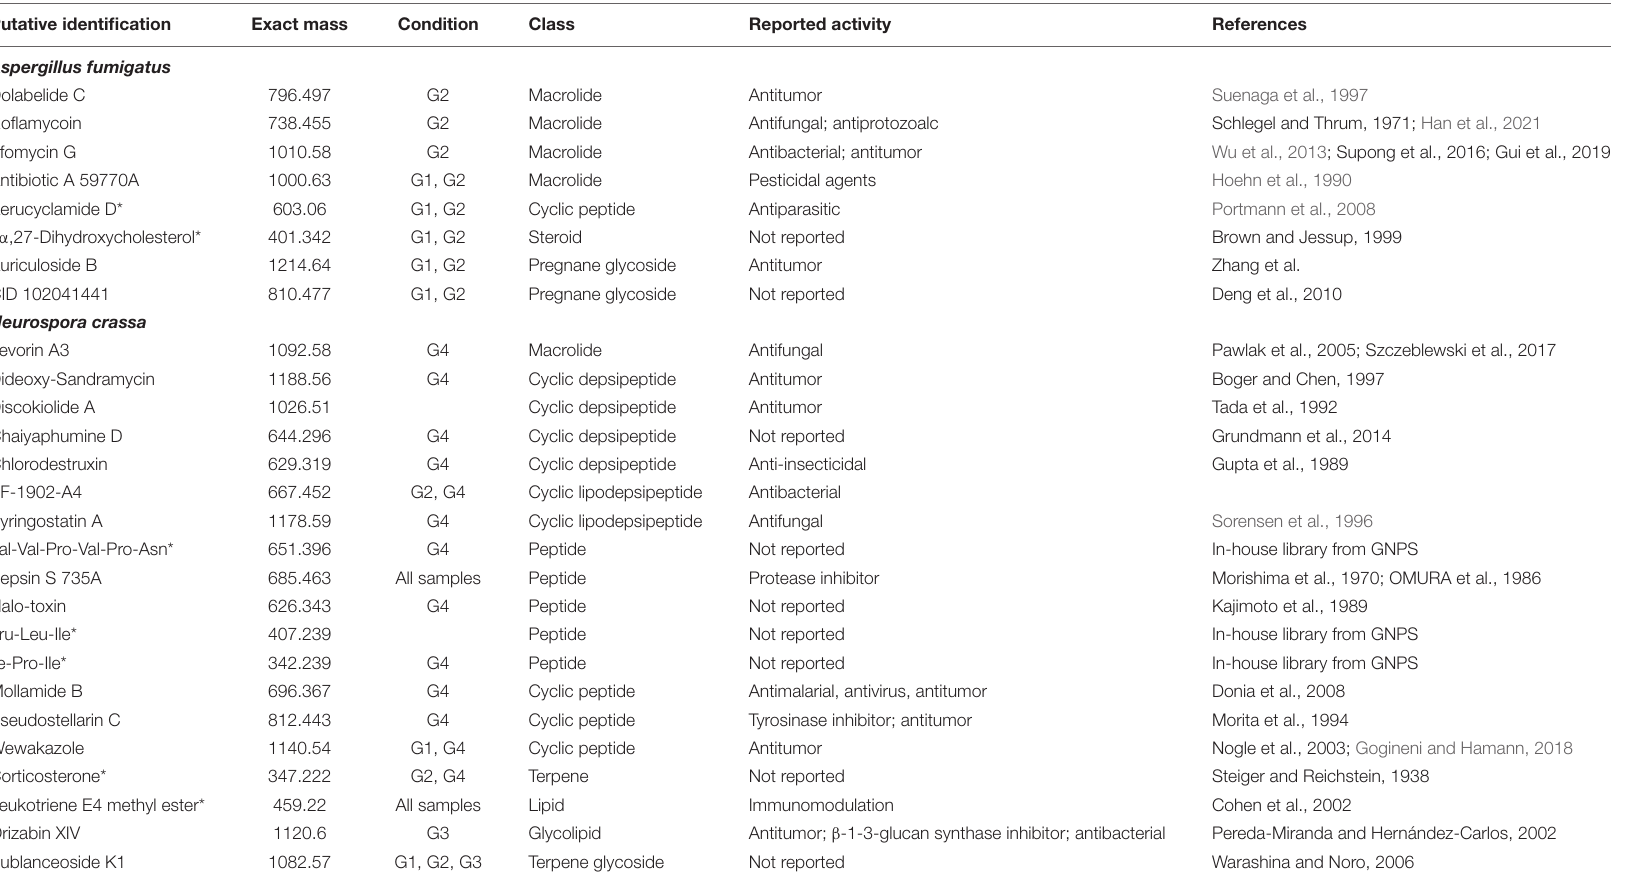
TABLE 3 | Untargeted LC-MS/MS analyses of A. fumigatus and N. crassa extracts derived from ionic liquid supplemented cultures suggests the accumulation, among other metabolites of macrolides and peptides,